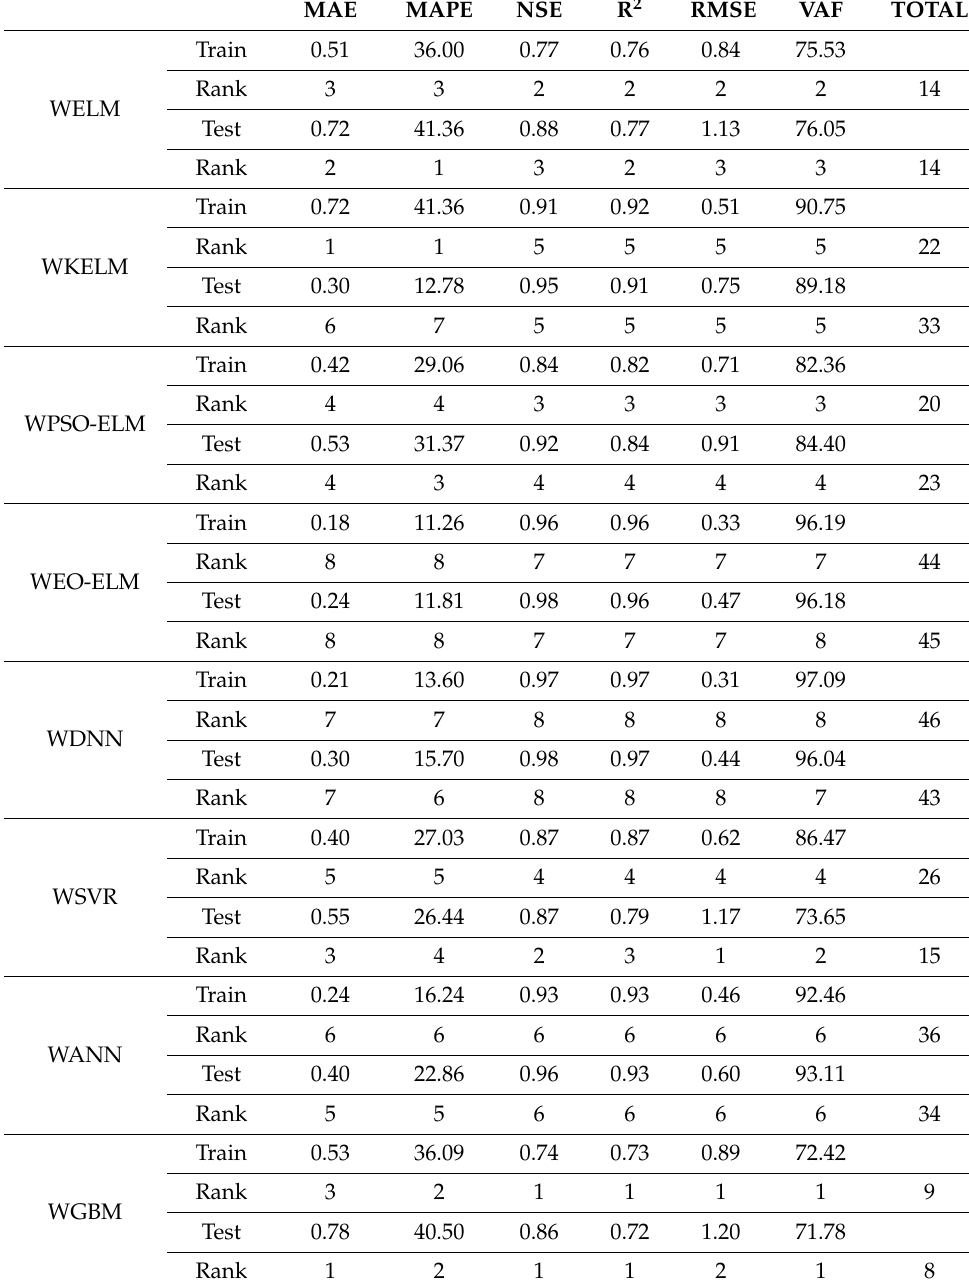
(Table 5). It is evident from Table 5 that WEO-ELM model with rank 44 in training and 45 in testing (having MAE = 0.18, MAPE = 11.26, NSE = 0.96, R 2 = 0.96, RMSE = 0.33, VAF = 96.19 in training and MAE = 0.24, MAPE = 11.81, NSE = 0.98, R 2 = 0.96, RMSE= 0.47, VAF = 96.18 in testing) which is comparable with WDNN model with rank 46 in training and 43 in testing (having MAE = 0.21, MAPE = 13.60, NSE = 0.97, R 2 = 0.97, RMSE = 0.31, VAF = 97.09 in training and MAE = 0.30, MAPE = 15.70, NSE = 0.98, R 2 = 0.97, RMSE = 0.44, VAF = 96.04 in testing). Figures 14 and 15 exhibit better prediction performance of WEO- ELM and WDNN in the train and test case respectively compared to other models with their linear equations for predicted and measured values. Table 5. Wavelet-based models’ performance evaluation of the catchment Fal at Tregony. MAE MAPE NSE R 2 RMSE VAF TOTAL Train 0.51 WELM